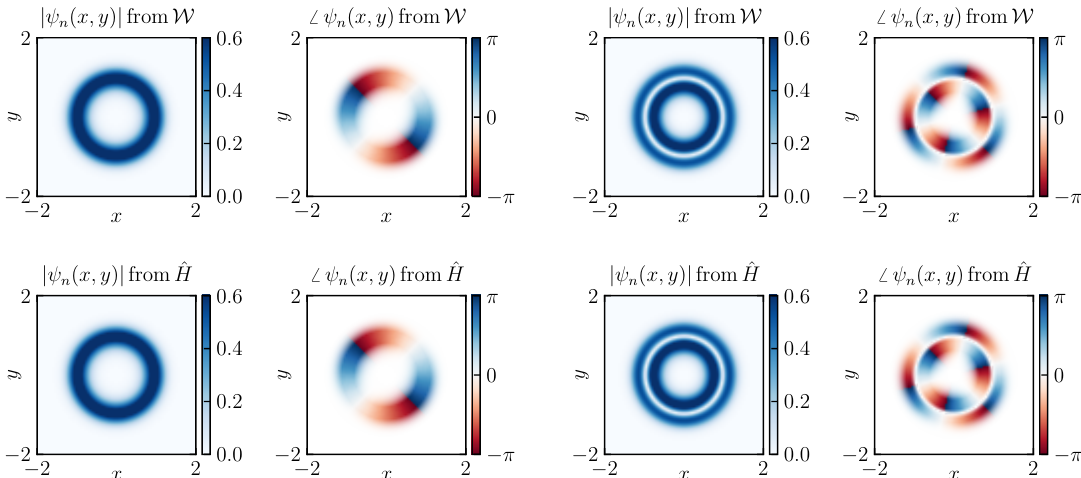
| and phase ∠ ψ of classical eigen- Figure 9: Comparison of absolute value | ψ n n states obtained from the Gibbs distribution (top row) and quantum eigenstates obtained solving the stationary Schrödinger equation (bottom row) for a two- dimensional potential in the presence of a magnetic field. Inverse temperature β = 0.5, potential corresponding to Eqs. (87) and (88) with m = ω = 1, δ = 2, Φ = π , and ε = ħ h = 0.1. Transparency for the phase is set by the absolute value in order to avoid numerical noise where the absolute value is